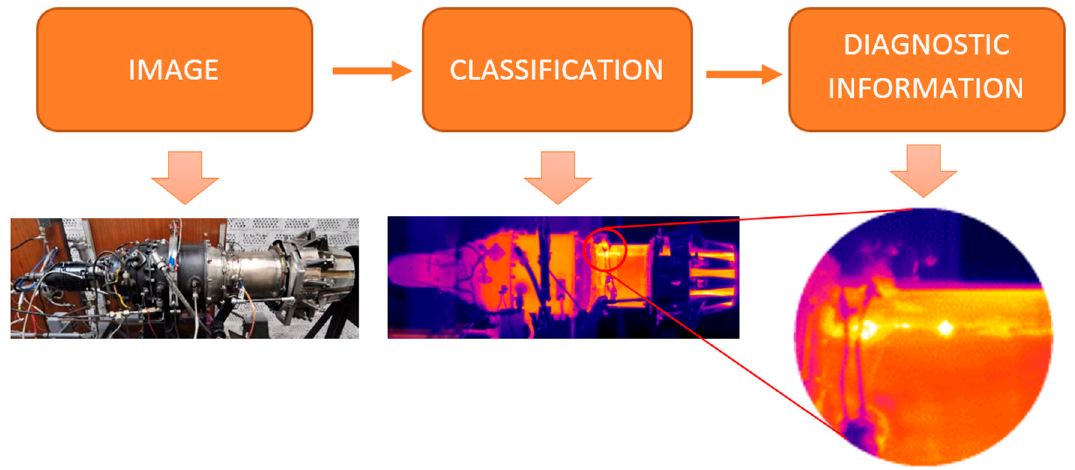
Figure 1. Procedure for the detection of temperature anomalies in engine casings by analyzing an infrared image.